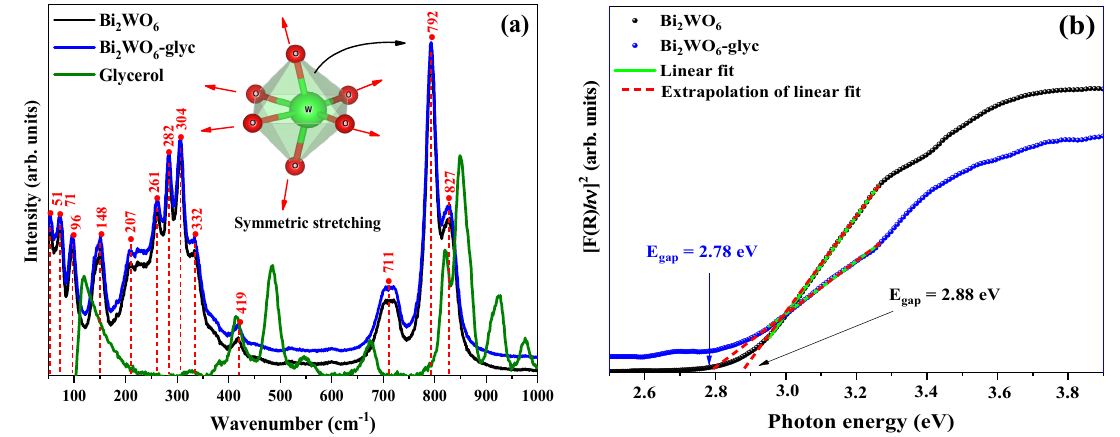
Figure 2. ( a ) Raman spectroscopy from 85 to 1000 cm − 1 and ( b ) [F(R) h ν ] 2 versus photon energy from UV-Vis by di ff use reflectance for Bi 2 WO 6 and Bi 2 WO 6 -glyc and experimental Raman spectra of